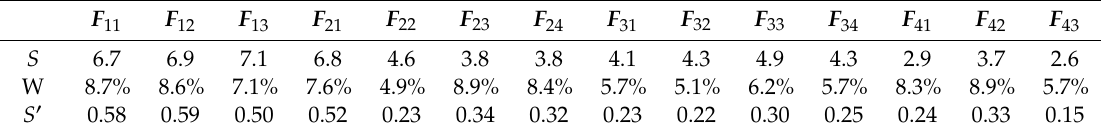
Table 9. The calculation of the severity.